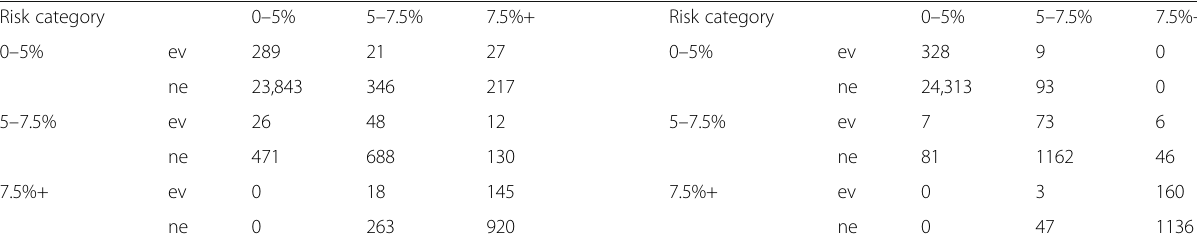
Left: rows — categories defined by the reduced model (controlling for age, total cholesterol, HDL cholesterol, systolic blood pressure and diabetes) and columns — categories defined by the reduced model + current smoking Right: rows — categories defined by the reduced model and columns — categories defined by the reduced model + uninformative